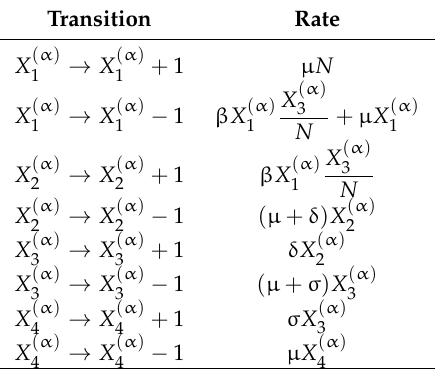
Table 1. Transitions and their rates for a birth and death process depicting a stochastic SEIR